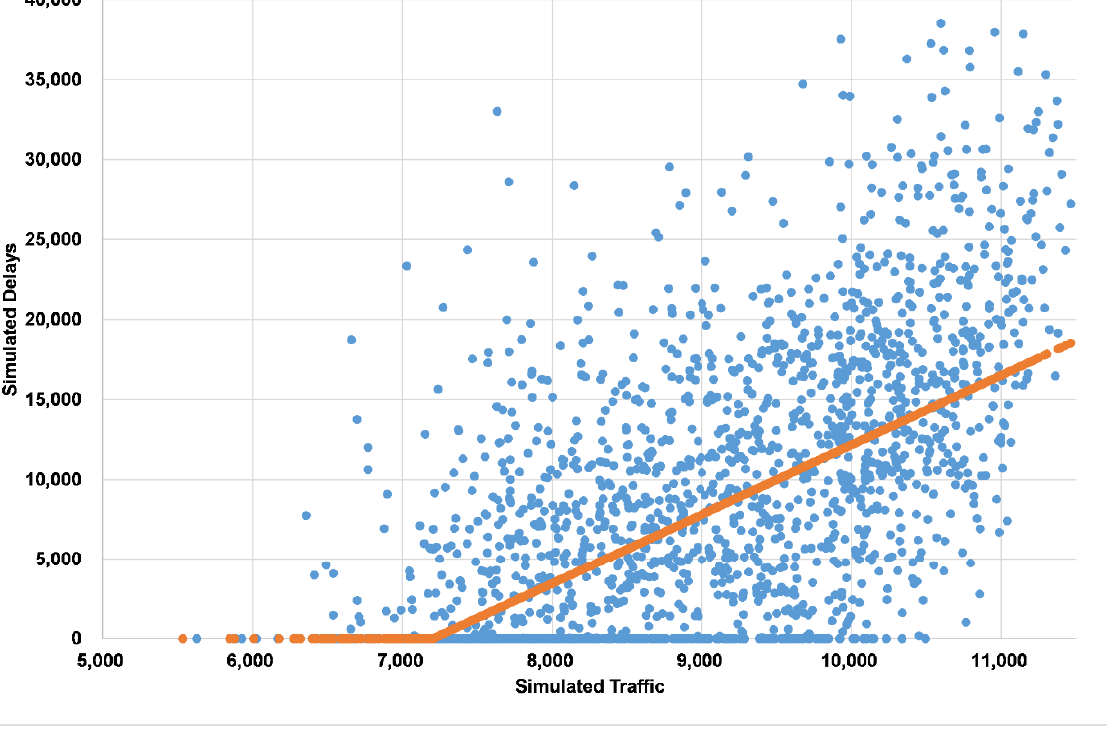
Figure 11. Simulation of daily Delays (five first simulations for 2019) The proposed model predicts the delays as a function of the number of flights. Other explanatory variables not considered in this model as well as the volatility inherent in this relationship cause